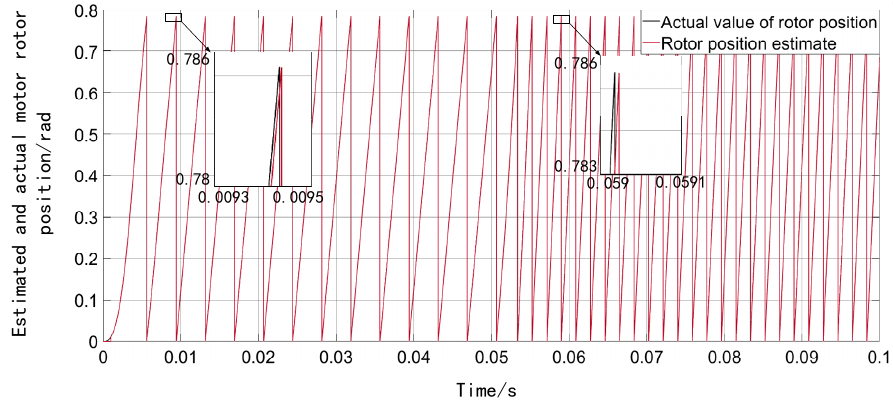
Figure 10. Comparison chart of the motor rotor position of the new and improved SMO at high speed.